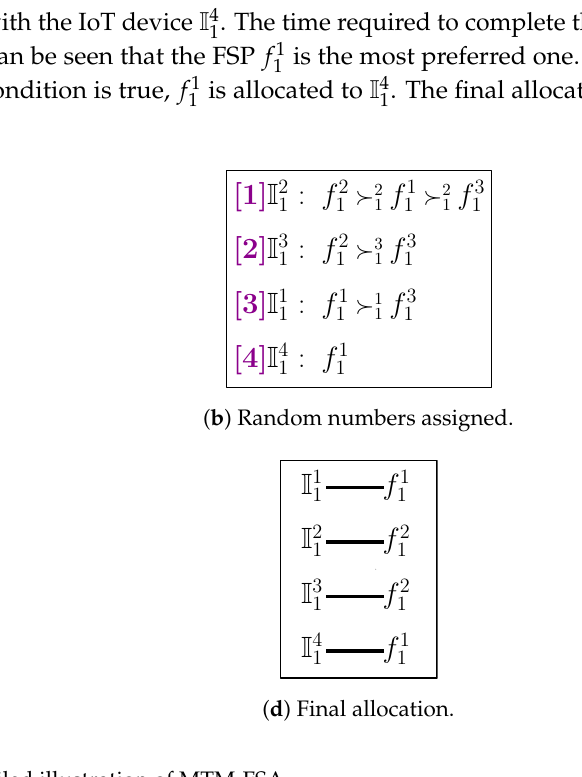
Figure 5. Detailed illustration of